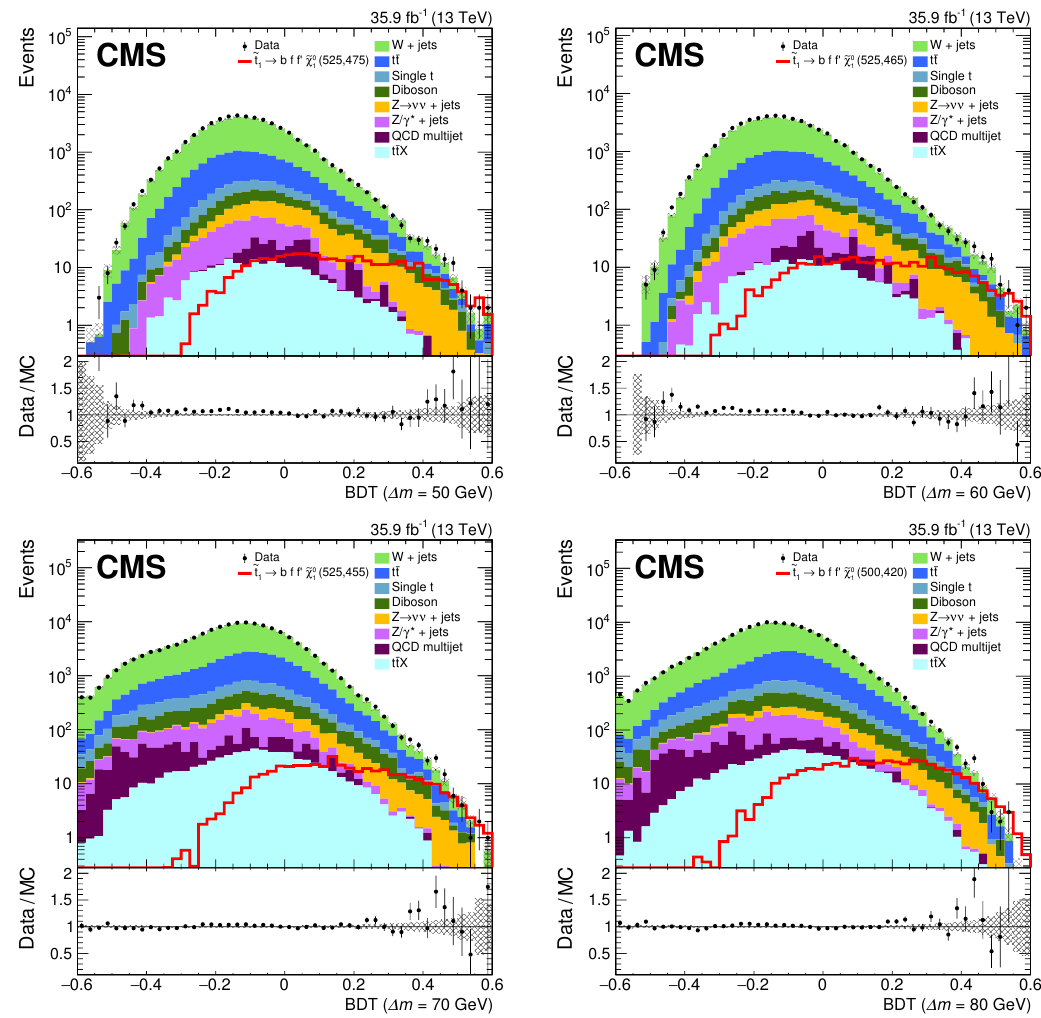
Figure 5 . Distributions of the BDT output at the preselection level in data and simulation in 10 GeV steps of (cid:1) m from 50 (top-left) to 80 GeV (bottom-right). For each case, a representative ( m ( t 1 ) ; m ( (cid:31) 0 )) signal point is also shown, but is not added to the SM background. The shaded 1 area on the Data/MC ratio represents the statistical uncertainty of the simulated e e